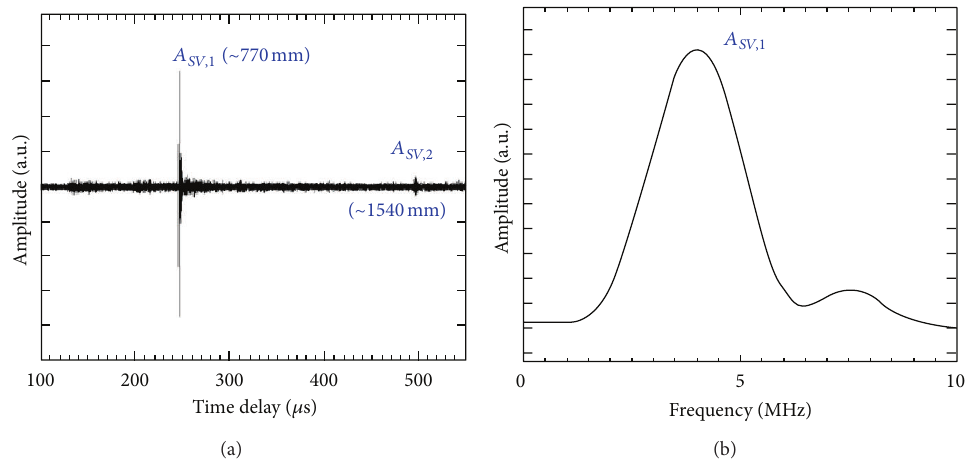
Figure 17: Measured anti-symmetrical PAWs reflected from the edge opposite to the IUT (experiment performed at 150 ∘ C). (a) Time domain signal and (b) frequency spectrum of the 1st round trip echo signal.